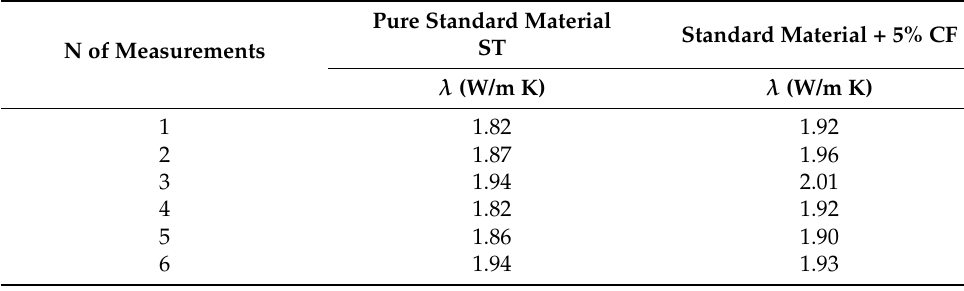
Table 4. Thermal conductivity obtained from measurements on the standard and doped (ST with 5% of CFP) bentonitic grouts.